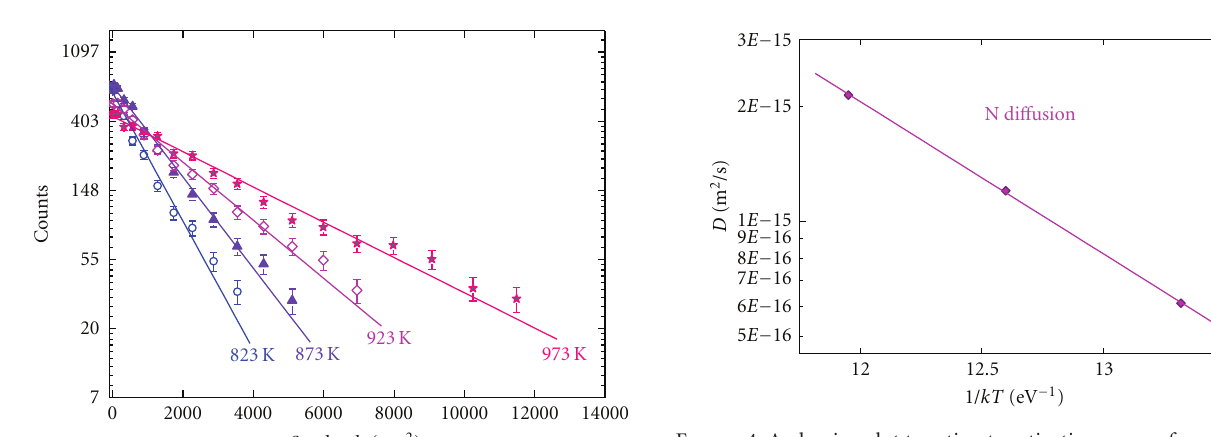
Figure 4: Arrhenius plot to estimate activation energy for nitrogen di ff usion in D9